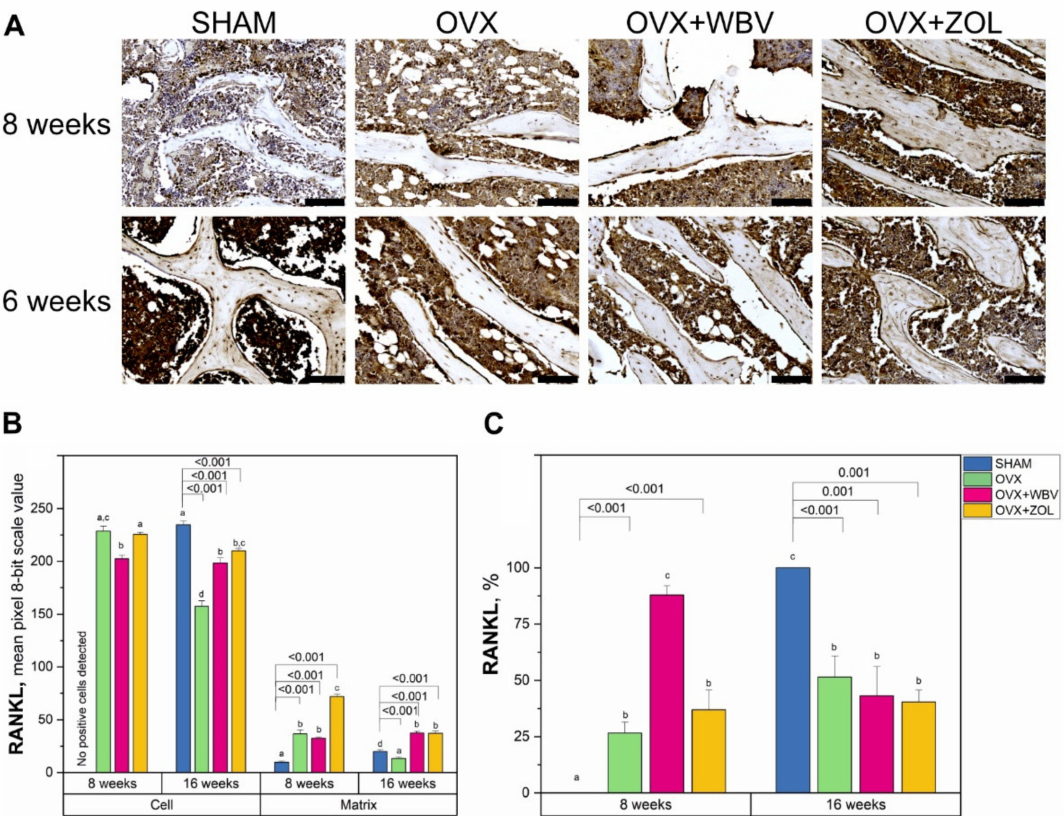
Figure 5. ( A ) Representative images of the immunohistochemical reactions for receptor activator of nuclear factor kappa-B ligand (RANKL) in the trabecular bone of femora from controls (SHAM surgery), ovariectomized rats (OVX), ovariectomized rats with whole body vibration (OVX + WBV), or Zoledronic acid (OVX + ZOL). All the scale bars represent 100 µ m. ( B ) Bar graphs show the intensity of expression of RANKL in cells (osteocytes) and matrix measured by the comparison of the pixel brightness value in the microscopic images converted to 8-bit grayscale—the higher the pixel value, the higher the intensity of the immunohistochemical reaction. ( C ) The percentage of cells with a positive response. Data are presented as mean ± SE with corresponding statistical analysis. Statistically significant differences between groups (at p < 0.05) are indicated by a, b, c, and d letters. Dunnett post-hoc significant p -values are placed over